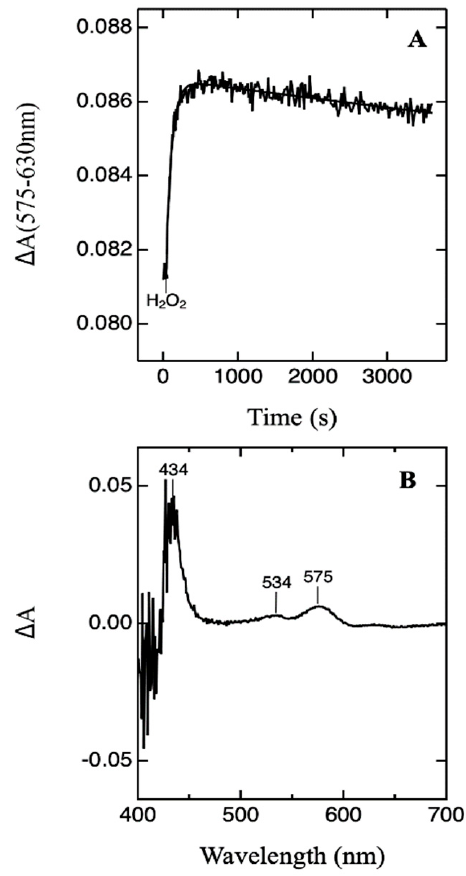
Figure 3. Production of the ferryl F • state of cytochrome oxidase by H 2 O 2 . ( A ) The kinetics of the formation of the F • intermediate by the reaction of the oxidized CcO (49 μ M) with H 2 O 2 (5.4 μ M) at 5 °C and its subsequent endogenous decay registered by the absorbance change Δ A (575–630 nm). The arrow (H 2 O 2 ) shows the time of peroxide injection. ( B ) The difference spectrum obtained after the subtraction of the spectrum of the initial oxidized CcO from the spectrum collected at the time (600 s) when the absorption change Δ A (575–630 nm) reached the maximum. The arrow (H 2 O 2 ) shows the time of peroxide injection. The buffer was 39 mM potassium phosphate, pH 5.7, 12.5 mM K 2 SO 4 , 0.6% DM and superoxide dismutase (30 units/mL).